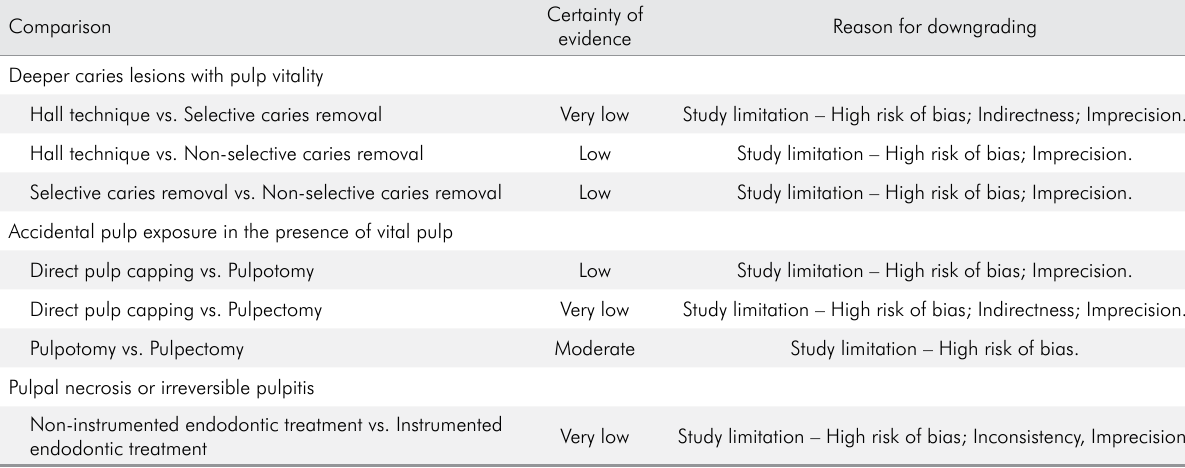
Table 2. Certainty of evidence and reason for downgrading in accordance with the initial pulp health condition.